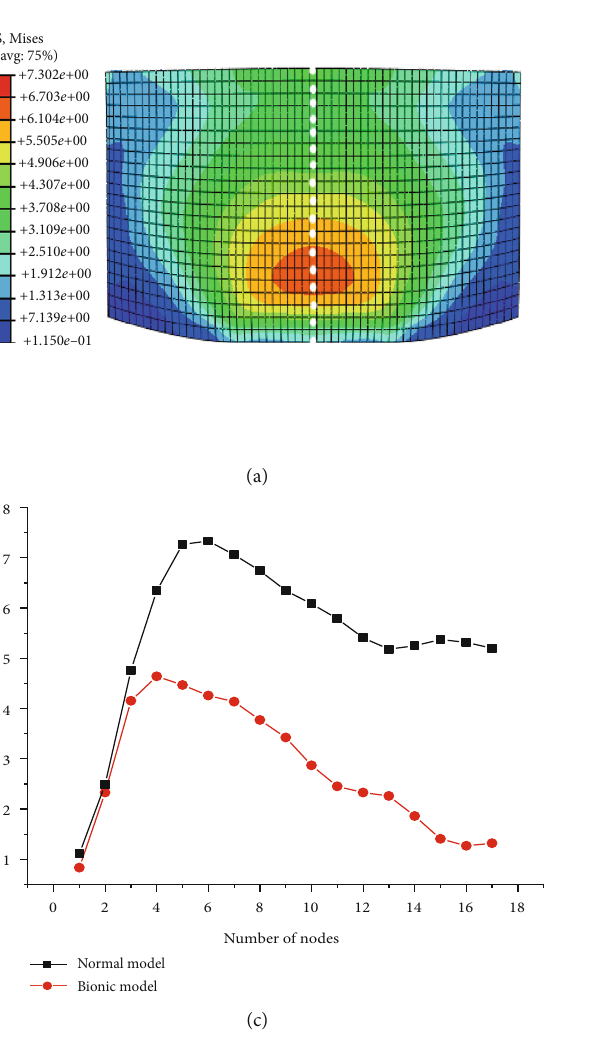
Figure 9: (a) Stress nephogram on the longitudinal section of the epidermal layer; stresses at di ff erent nodes when the loading speed onto the top plates was (b) 1m/s or (c) 10m/s; (d) peak internal stress on the epidermal layer in both models at di ff erent loading